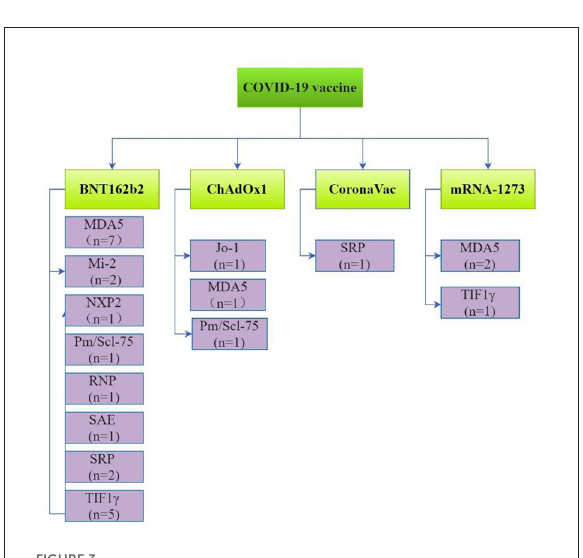
FIGURE3 Myositis antibodies associated with individual CoV-19